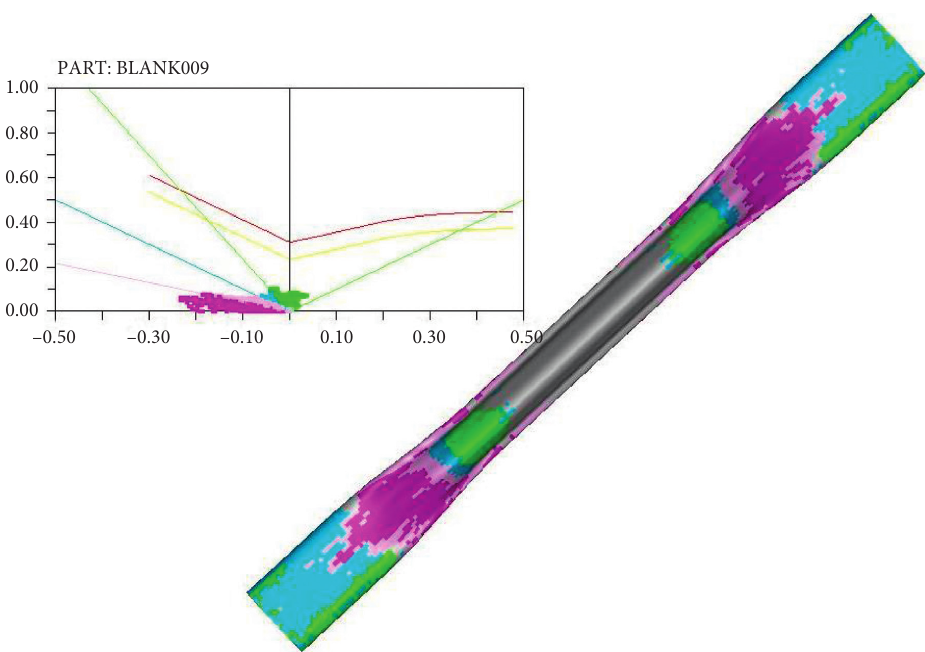
Figure 20: FLD of A